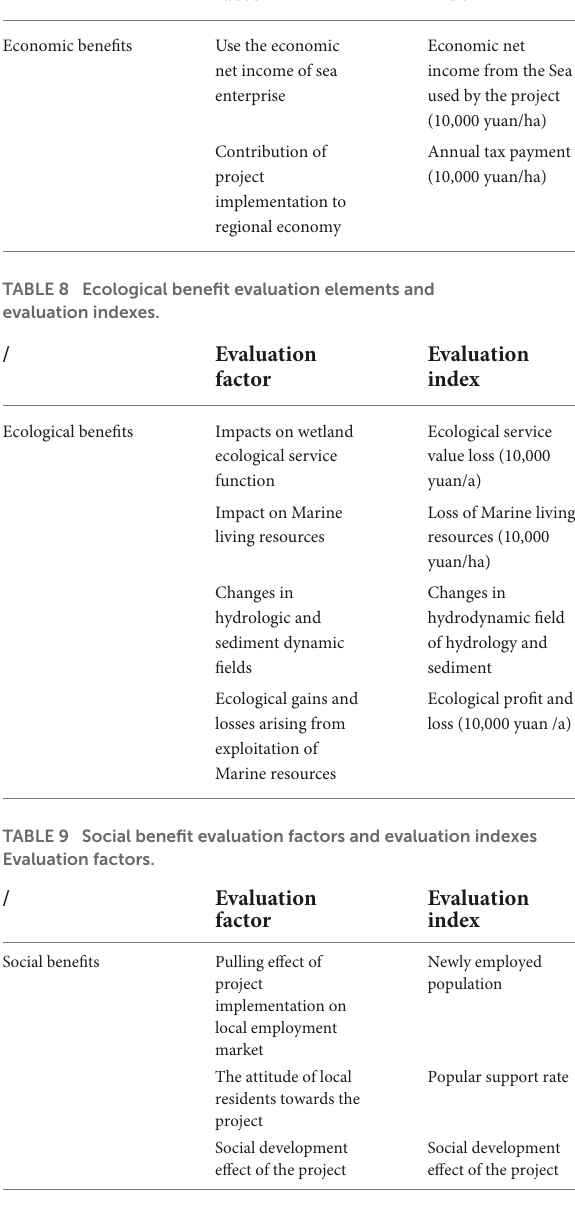
TABLE 7 Economic benefit evaluation elements and evaluation indexes.